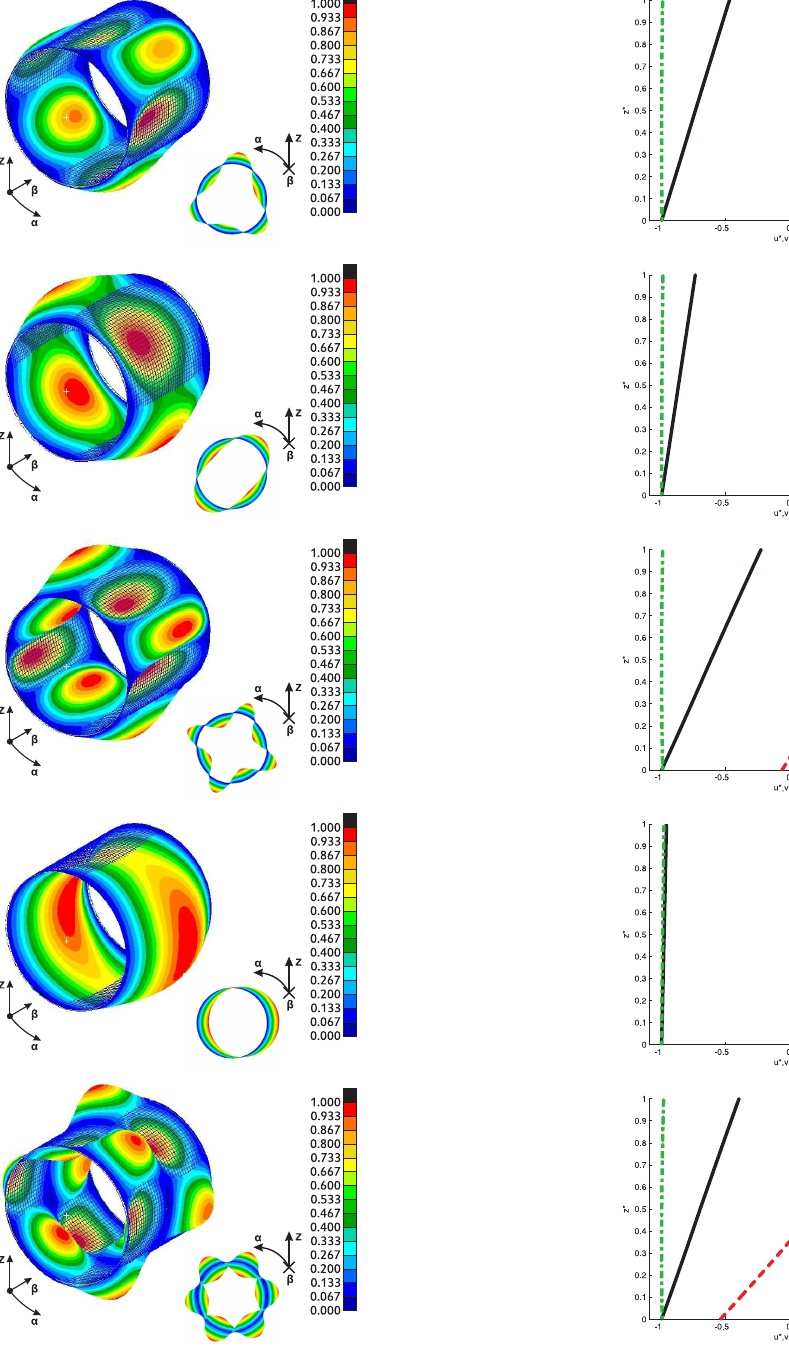
Figure 11: Fourth benchmark, simply supported cylinder made of aluminium alloy and titanium alloy with thickness ratio R α /h=10. First five frequencies (with transverse displacement w ≠ 0) via 2D FE solution (on the left) and via 3D exact solution (on the right).